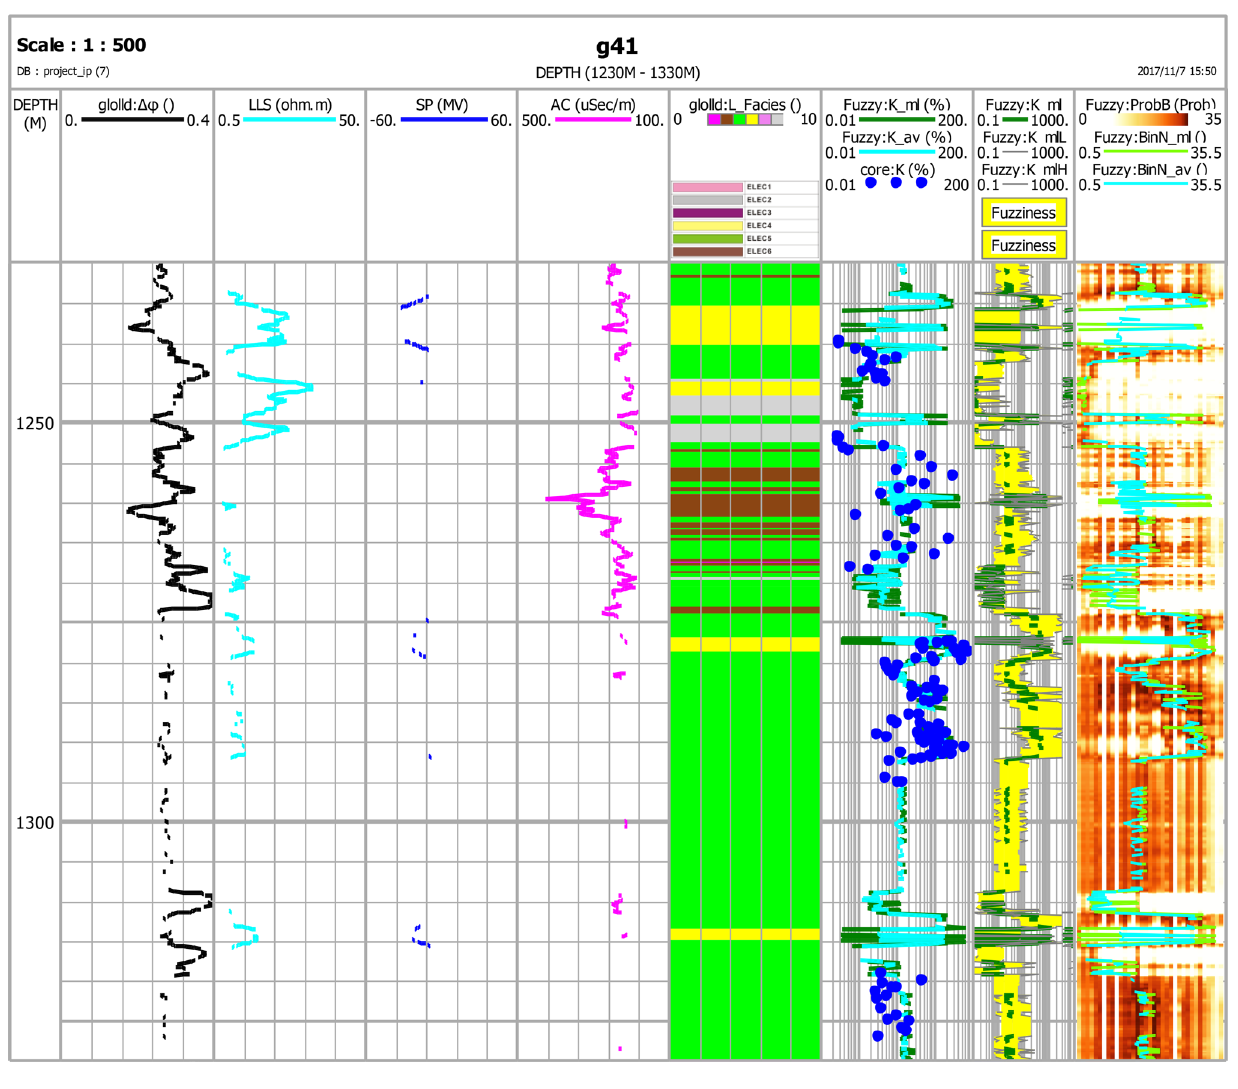
Fig. 22 The well plot of Well G41 between 1230 and 1330